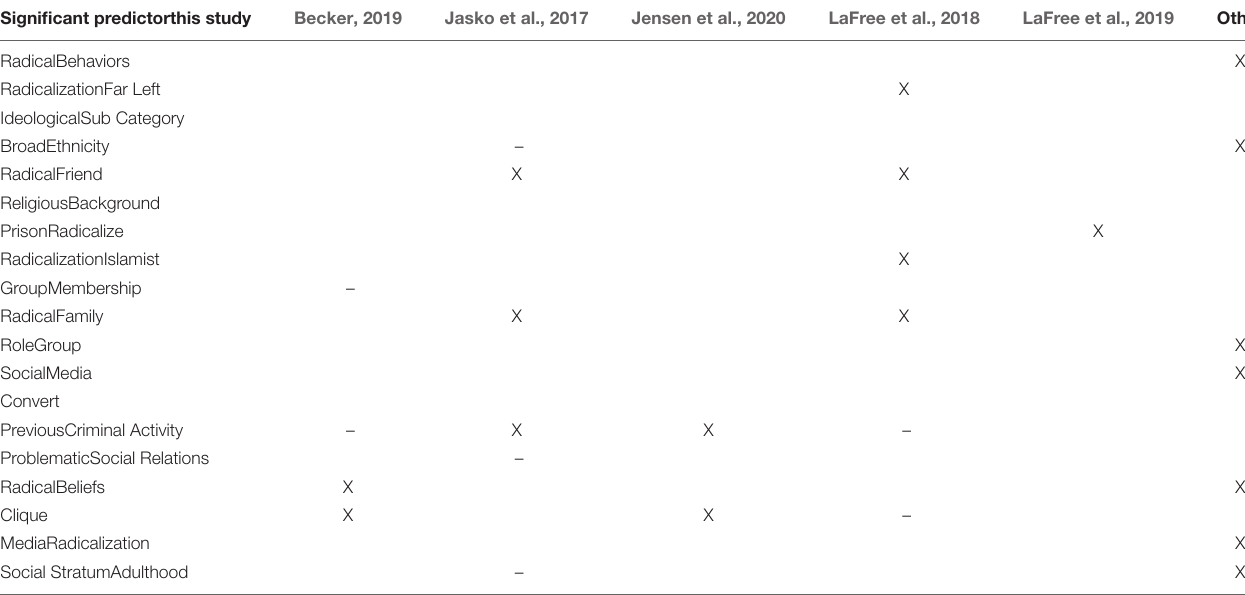
TABLE 6 | Predictor variables in our and earlier